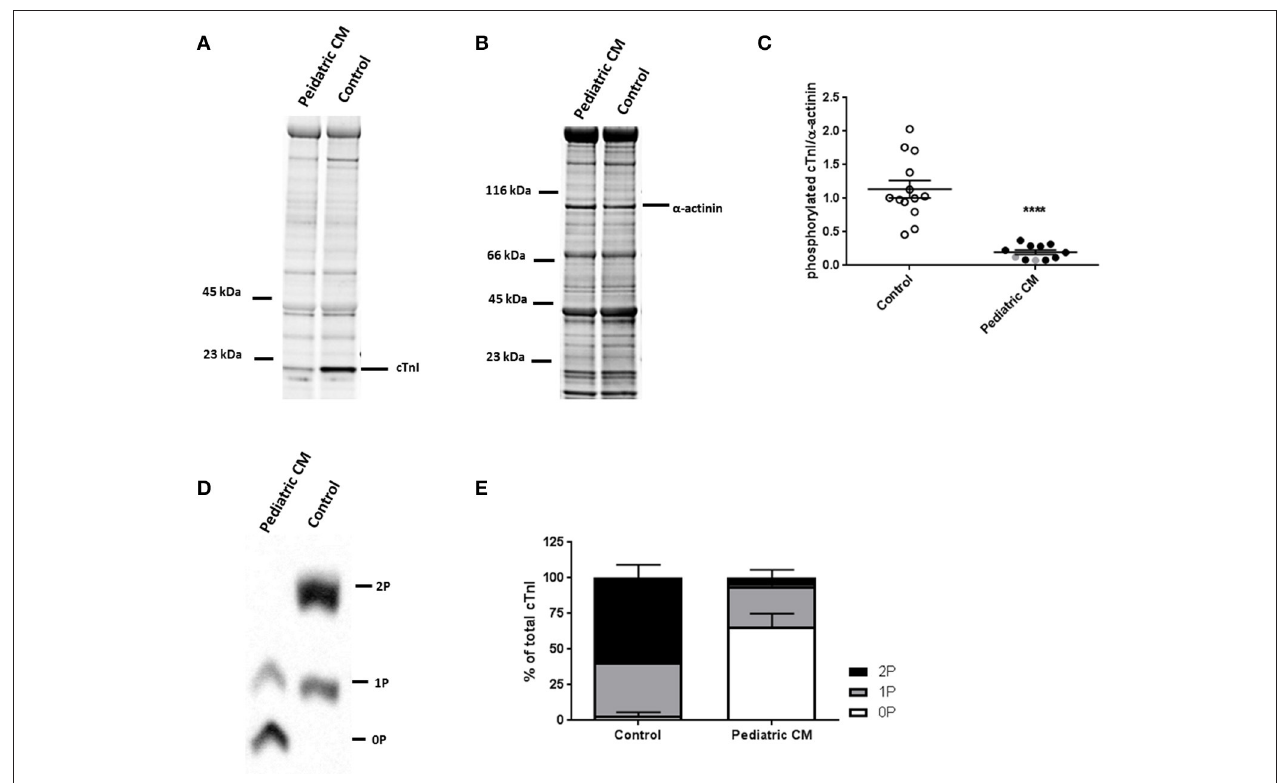
FIGURE 3 | Hypophosphoryalation in pediatric CM compared to controls. (A) ProQ staining identifying phosphorylated proteins of pediatric CM and control samples. (B) Corresponding SYPRO staining identifying proteins of pediatric CM and control samples. (C) cTnI phosphorylation was significantly lower in pediatric CM ( N = 11) compared to controls ( N = 13, p < 0.0001). (D) Phostag showed separation of non-, mono-, and bisphosphorylated cTnI. (E) While controls ( N = 11) showed predominantly mono- and bisphosphorylated cTnI, pediatric CM samples ( N = 11) showed mostly non-phosphorylated cTnI. Measurements obtained from samples derived from patients with non-compaction cardiomyopathy are indicated in gray. **** p < 0.0001 vs.